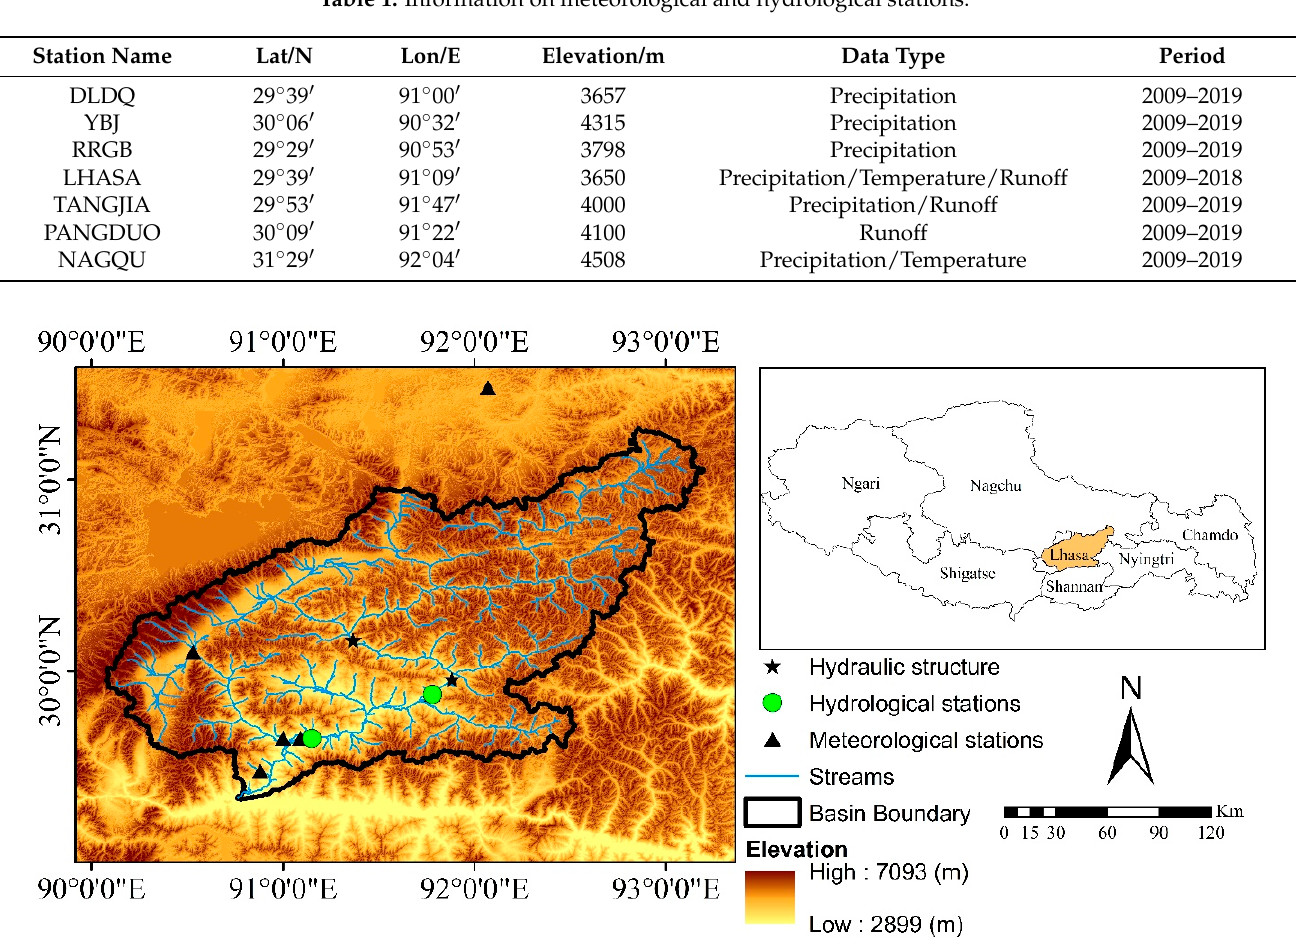
Table 1. Information on meteorological and hydrological stations.